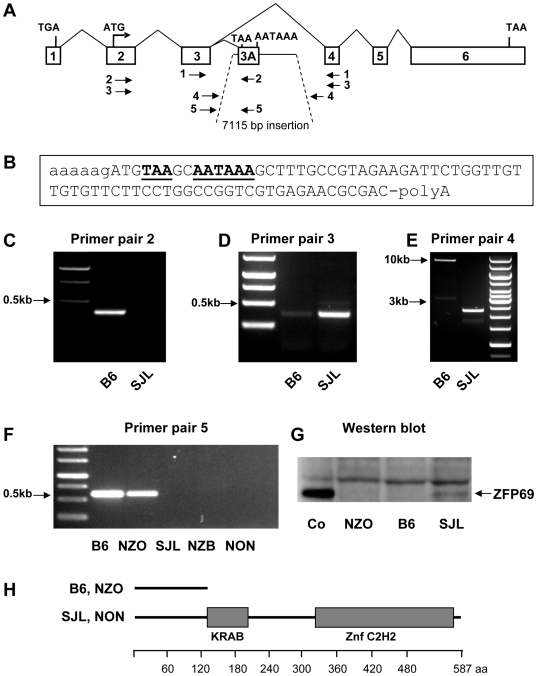
Loss-of-function of Zfp69 in NZO and B6 by alternative mRNA splicing and intronic polyadenylation.(A) Genomic organisation and PCR primer pairs used for characterization of Zfp69. (B) Sequence of the additional exon 3A (capital letters) that was polyadenylated and spliced to exon 3 as identified by 3′-RACE–PCR. (C,D) Identification of the cDNA variants in B6 and SJL by PCR with downstream primers derived from exons 3A and 4. (E) Detection of the 7 kbp insertion in intron 3 of B6. (F) allelic variation of Zfp69 in different mouse strains with known contribution of distal chromosome 4 to diabesity. (G) Western blot of nuclear extracts isolated liver of NZO, B6, and SJL mice. Co, recombinant ZFP69 generated by transfection of COS-7 cells with Zfp69 cDNA. (H) Model of the domain structure of ZFP69 and the truncated variant (B6, NZO).